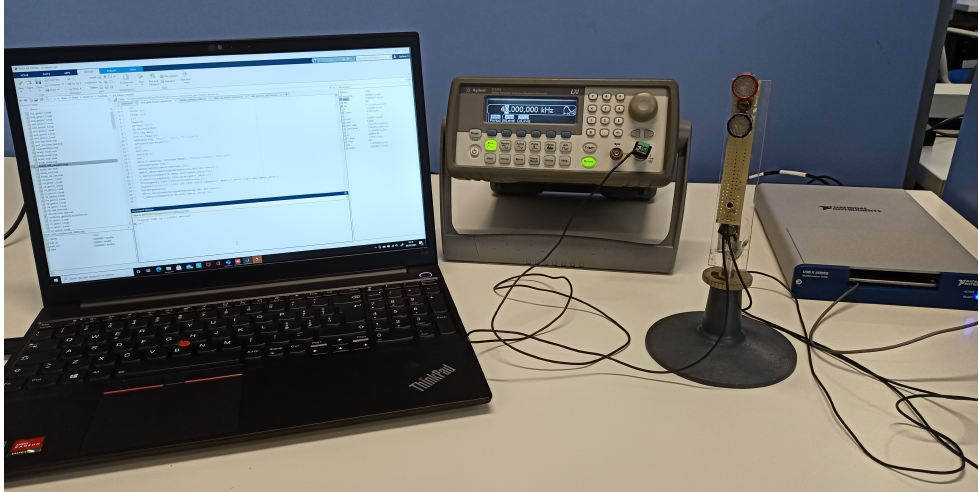
Figure 2. Picture of the proposed ultrasound-based person identification system. From left to right: a standard laptop used for signal processing, the waveform generator, the ultrasound transducers and the analog-to-digital